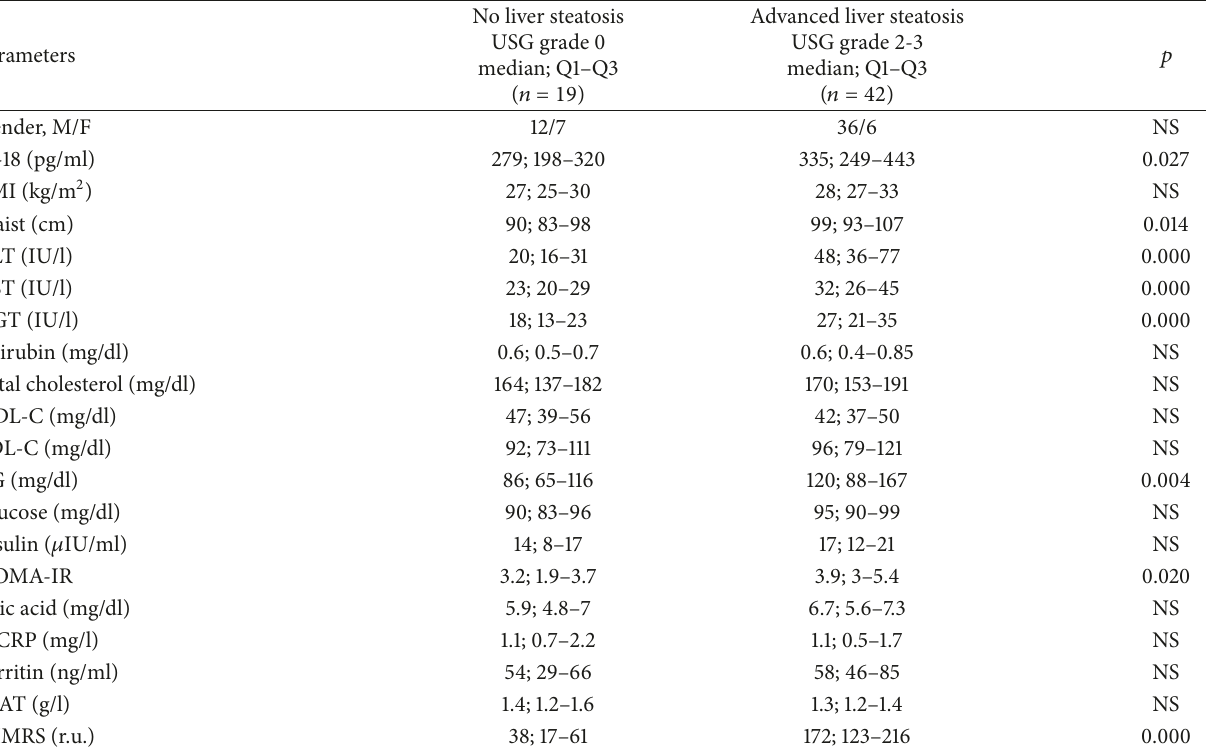
Table 3: Comparison of obese children without liver steatosis (𝑛 = 19) and with advanced liver steatosis (𝑛 = 42) evaluated in USG according to Saverymuttu et al.